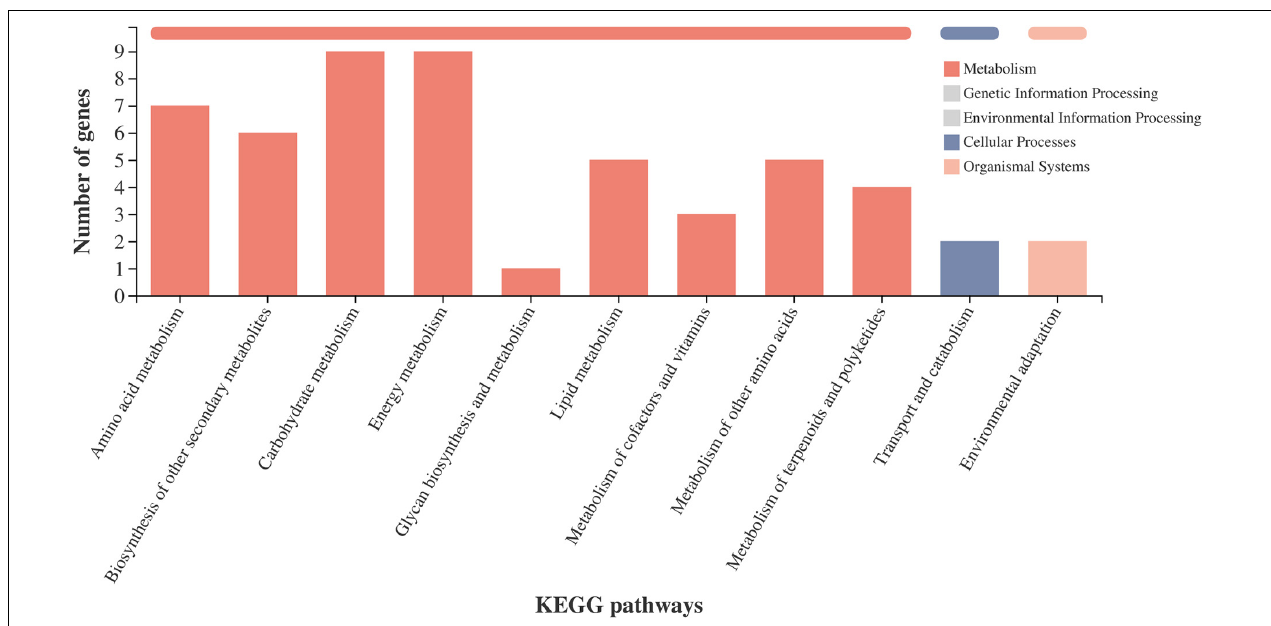
FIGURE 6 | KEGG pathway classification statistics. X -axis shows the name of the KEGG metabolic pathway; Y -axis shows the number of genes or transcripts annotated to the pathway. There are seven categories of KEGG metabolic pathways: metabolism, genetic information processing, environmental information processing, cellular processes, organismal systems, human diseases, and drug